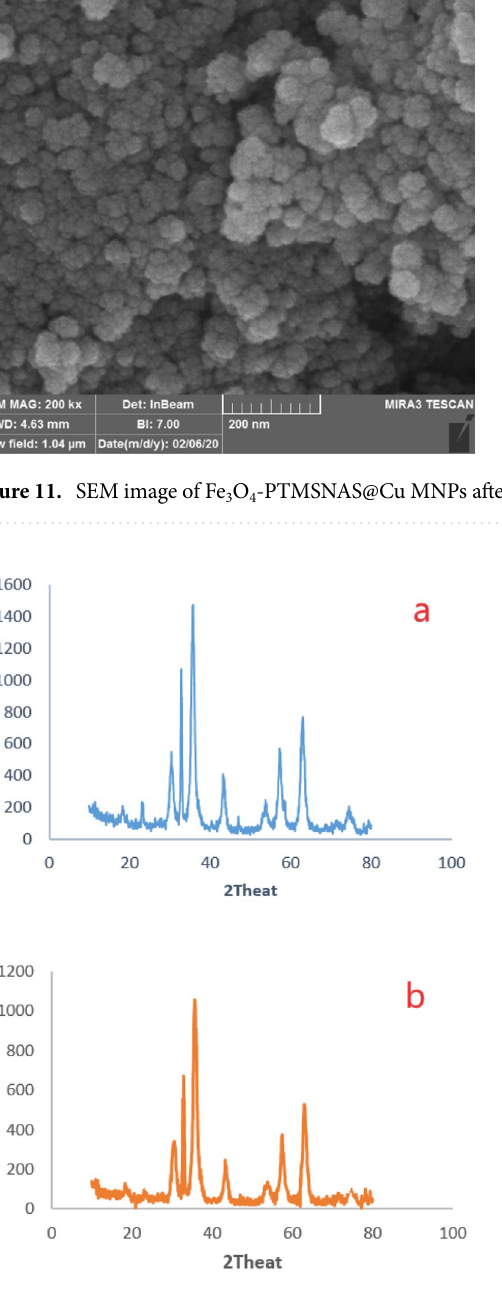
Figure 12. The XRD patterns of Fe 3 O 4 -PTMSNAS@Cu MNPs ( a ) and Fe 3 O 4 -PTMSNAS@Cu MNPs after recovery ( b